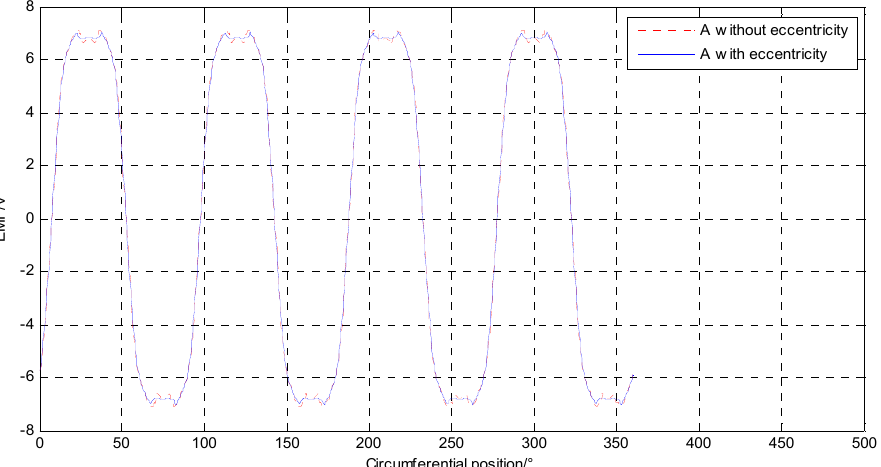
Figure 11. EMF of A-phase winding when the motor rotates once.